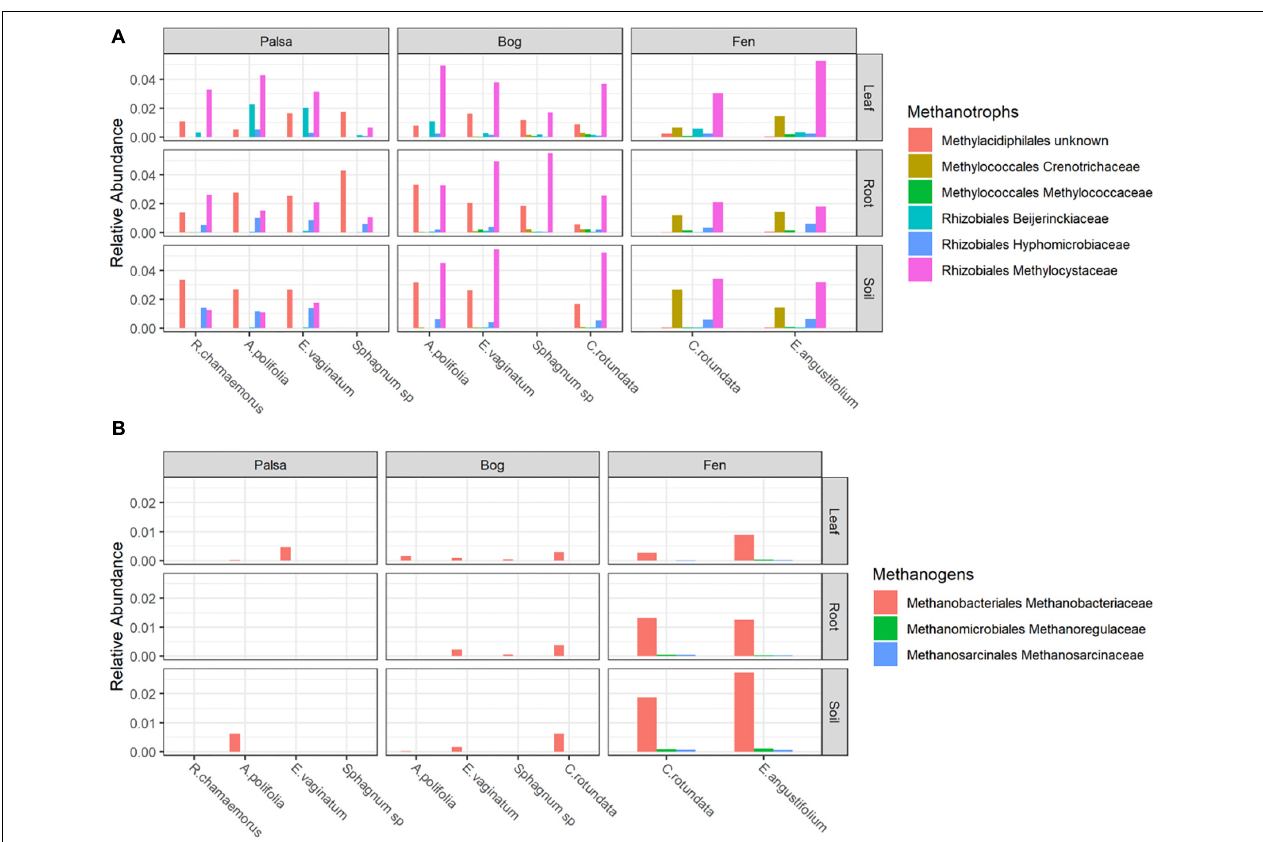
FIGURE 5 | Relative abundances of (A) Methanotrophs and (B) Methanogens, grouped by habitat and compartment. Colors indicate plant associates.